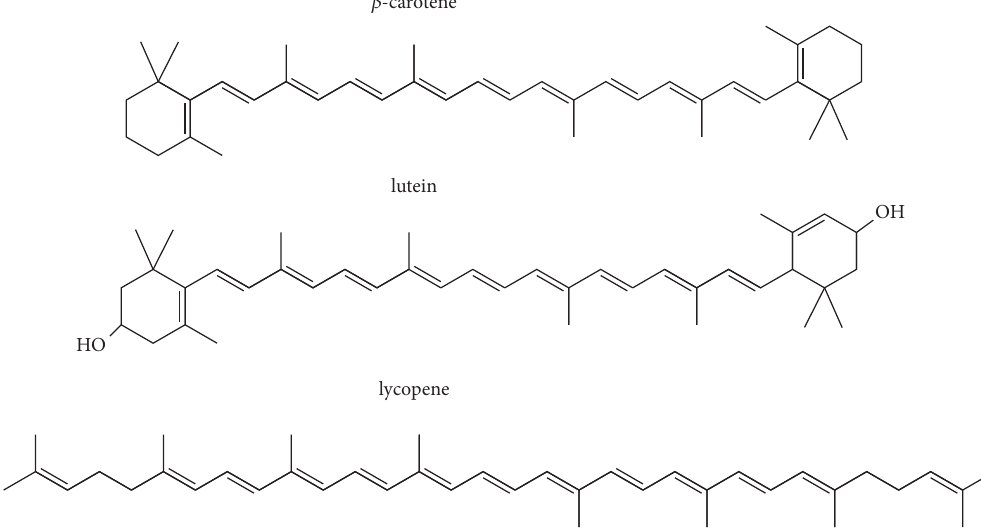
Figure 1: Chemical structures of β -carotene, lutein, and